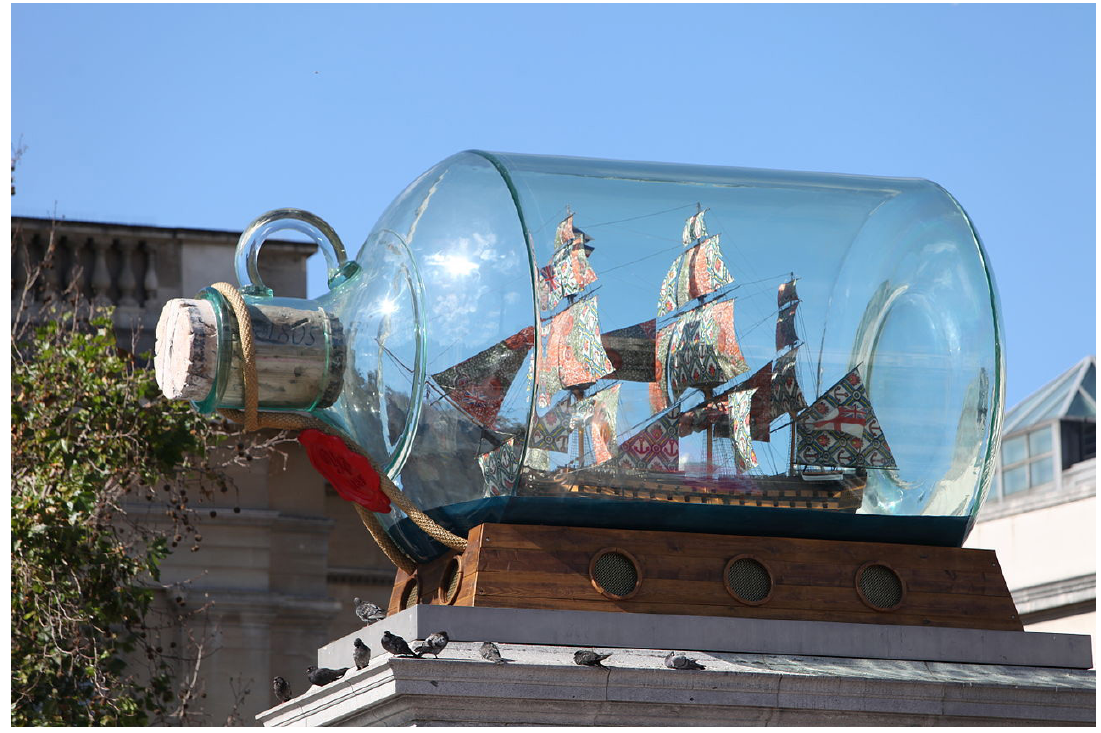
Figure 1. Yinka Shonibare’s Nelson’s Ship in a Bottle installed in Trafalgar Square, 2010. QuintinUK photograph, licensed